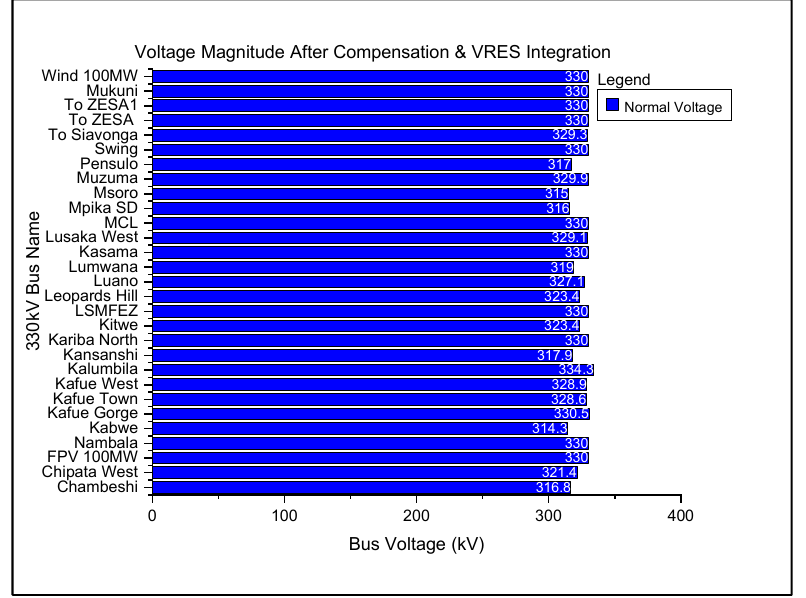
Figure 10. Showing bus voltage after adding network compensation and VRES.